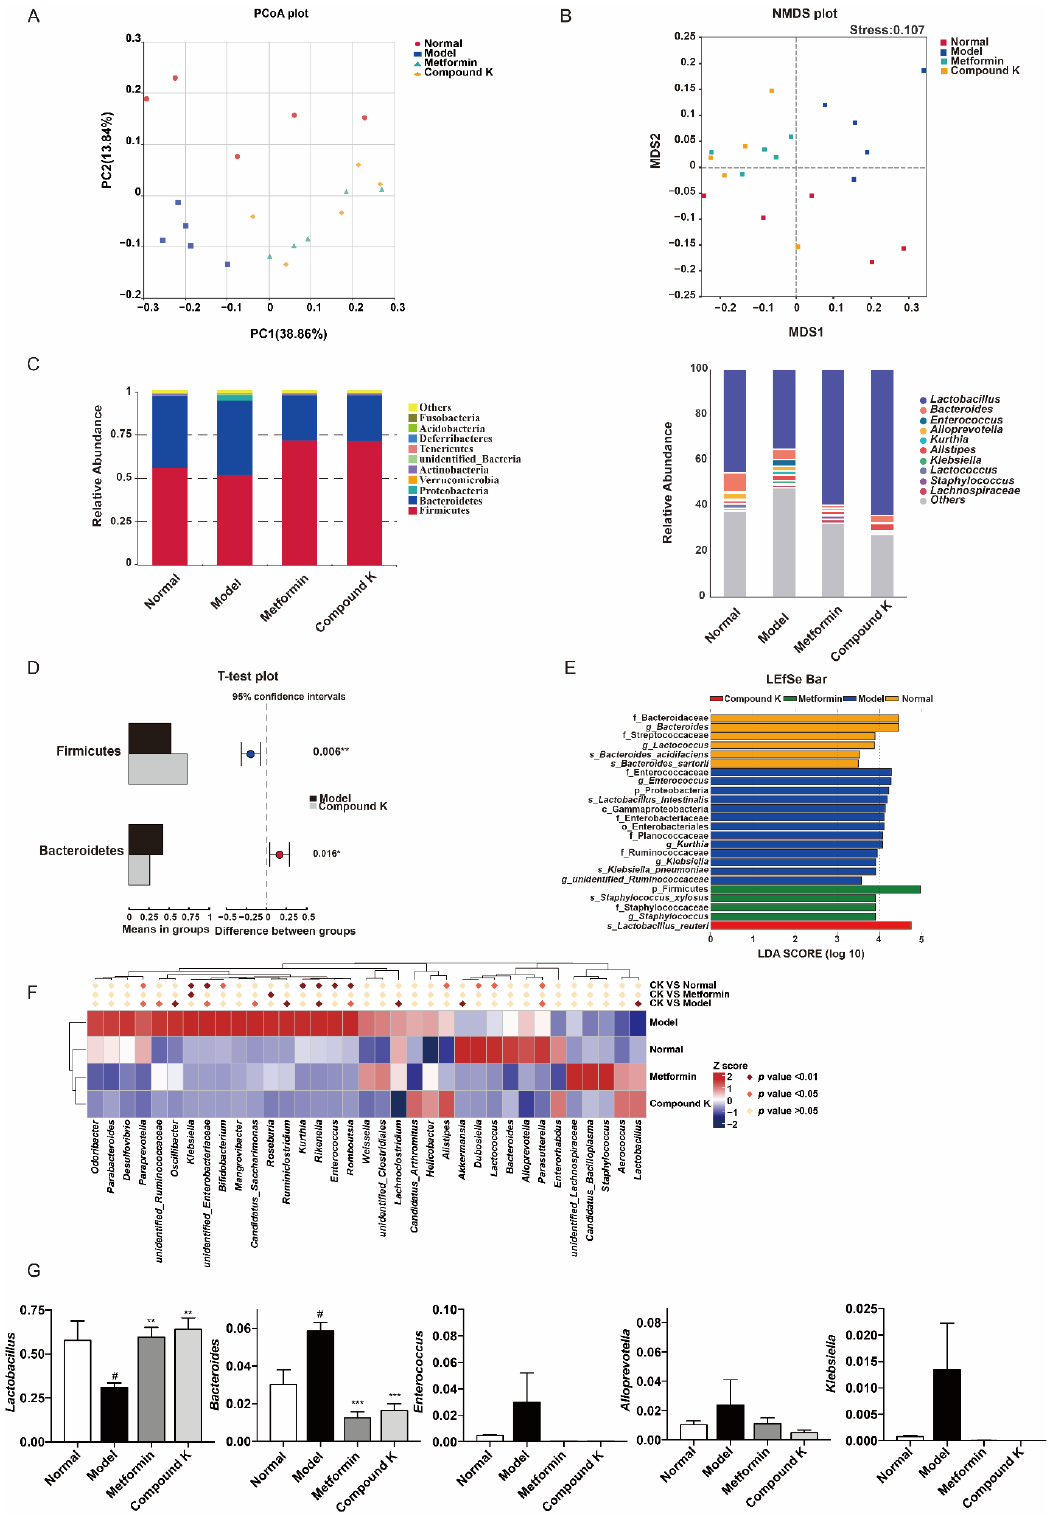
Figure 2. CK supplementation modifies the diabetic mice gut microbial composition to modulate renal function. ( A ) The difference of gut microbiota was analyzed in a principal coordinates analysis (PCoA) plot. The two principle coordinates (PC1-PC2) were 38.86% and 13.84%, respectively. ( B ) The difference in gut microbiota was analyzed in non-metrical multidimensional scaling (NMDS). The stress was 0.107. ( C ) Comparison of gut microbiota composition in four experimental groups at